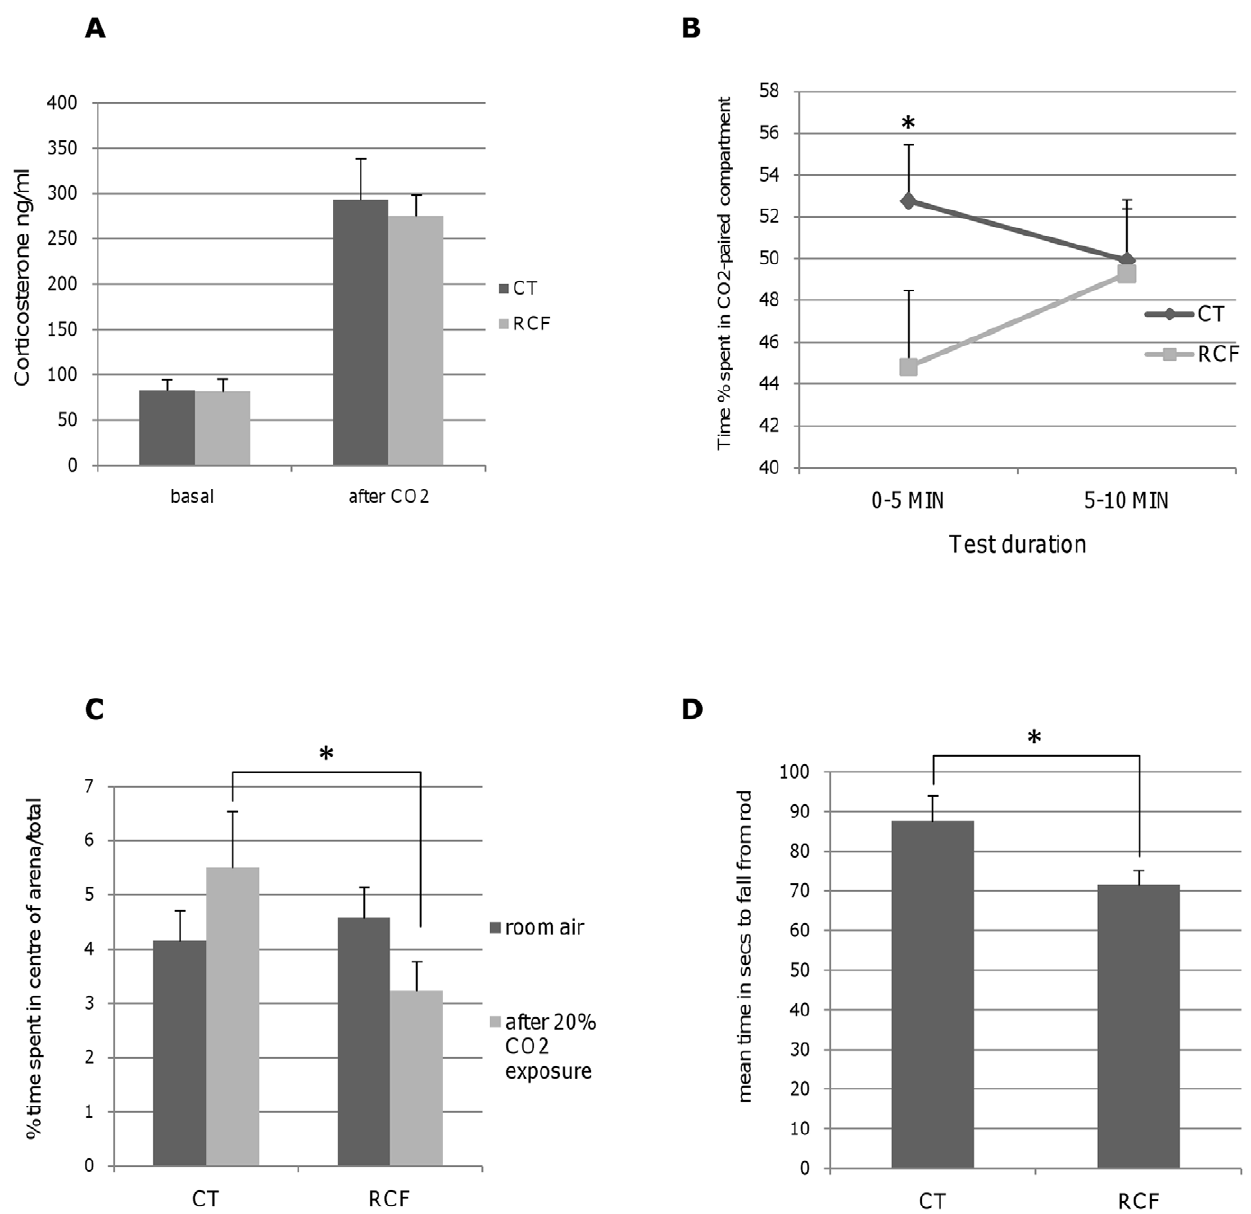
Figure 3. Behavioural and Endocrinological Phenotypes among RCF and CT subjects. A : Serum concentration of corticosterone. In both RCF and CT subjects corticosterone was significantly heightened (F 1,9 =49.71 p=0.0001) after 20 minutes of 6% CO 2 breathing compared to the basal values obtained in room air breathing; neither ‘postnatal treatment’ (RCF vs. CT) nor ‘postnatal treatment-by-air mixtures’ revealed differences for corticosterone serum concentrations (respectively F 1,9 =0.2 p=NS, and F 1,7 =0.08, p=NS). B : Place avoidance/preference towards environments with heightened CO 2 concentration (6% CO 2 air mixture): during the first five minutes of the test session, RCF individuals showed significantly higher tendency to avoid the compartment that had been previously paired with 6% CO 2 . (ANOVA-R : postnatal manipulation x time interval effect: F 1,22 =4.51, p , 0.05, Tukey HSD post-hoc test p , 0.02). C : Free exploratory test. The percentage of time spent at the centre of an arena was significantly influenced by the interaction of postnatal treatment-by-air mixtures (F 1,74 =4.03, p=0.048) whereby RCF subjects spent significantly less time than CT subjects after exposure to 20% CO 2 . Neither the ‘postnatal treatment’ (RCF/CT), nor the ‘air mixtures’ (normal air/20% CO 2 ) variables showed significant effects alone (respectively F 1,76 =1.90 p=NS, F 1,76 =0.13 p=NS). D : Latency to fall from the Rotarod. Analysis of variance showed that the performance at the Rotarod was significantly worse among RCF than CT subjects (F 1,67 =5.08 p=0.03), in that the former showed significantly shorter latency of fall from the rod. doi:10.1371/journal.pone.0018637.g003 D TV% increase shown by CT pups when they were exposed to 6% challenge, respectively: ml/min 53.10 6 18.22 vs.40.98 6 12.65, CO 2 -enriched air mixture, but no difference of D TV% in response p=0.009), whereas the mean respiratory frequency (f) did not differ significantly in RCF and CT pups during air, 10%O 2 , or to hypoxic air (10% O 2 ), or normal air, compared to CT pups (Figure 4A). The TV increase determined higher MV amongst RCF 6%CO 2 conditions. The RCF procedure also appeared to affect than CT pups in response to 6%CO 2 (mean MV during 1 st 6%CO 2 individual sensitivity to 6%CO 2 in a stable way, in that adult mice